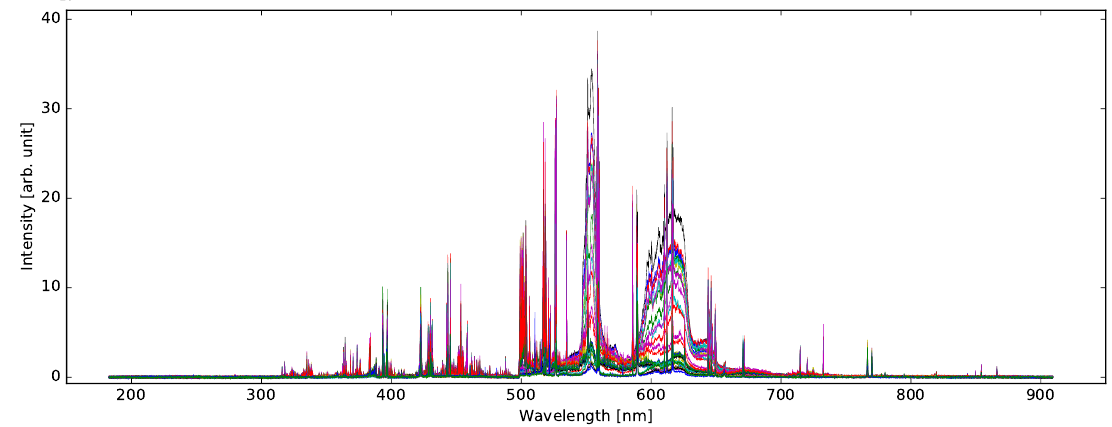
Figure 1. First spectrum of each